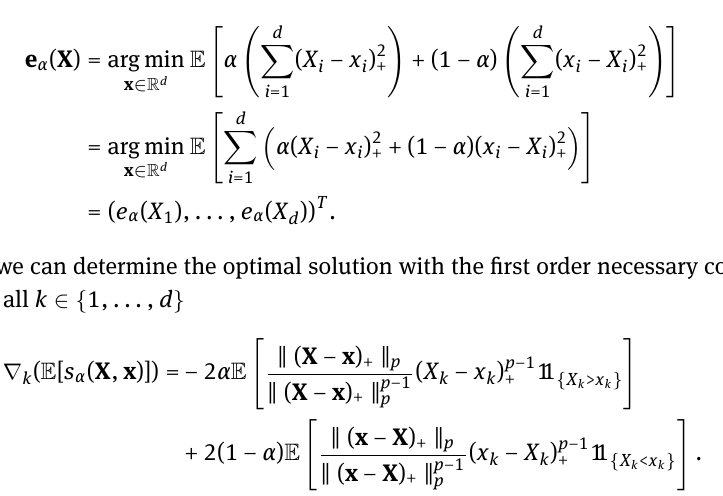
When p = 2, the expectile is not taking into account the dependence. Indeed, the L 2 −expectile is com- posed by the marginal univariate